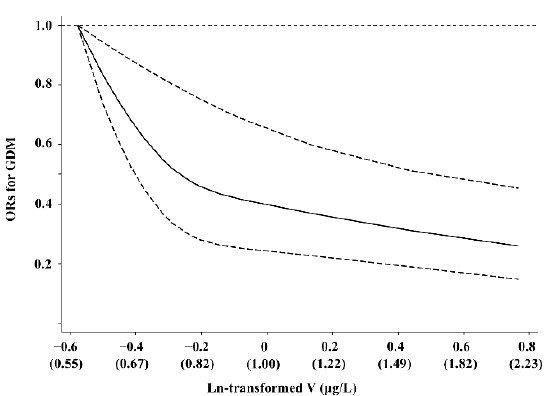
Figure 1. Representation of restricted cubic spline regression for ln-transformed plasma V and GDM. The solid line indicated ORs derived from restricted cubic spline regression, with knots at 25th, 50th, and 75th percentiles of ln-transformed plasma V concentrations and dashed lines indicating 95% CIs. Results were adjusted with age, gestational age at blood sample collection, pre-pregnancy body mass index, family history of diabetes, drinking habits, and smoking status. V, vanadium; GDM, gestational diabetes